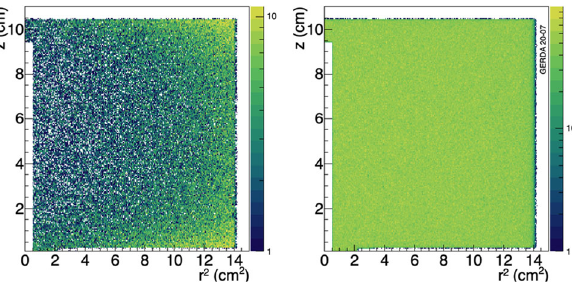
Fig. 21 Events distributions across the detector bulk from simulated 208 Tl DEP (left) and 0 νββ decay (right) events. The position of an event corresponds to the barycentre of individual energy